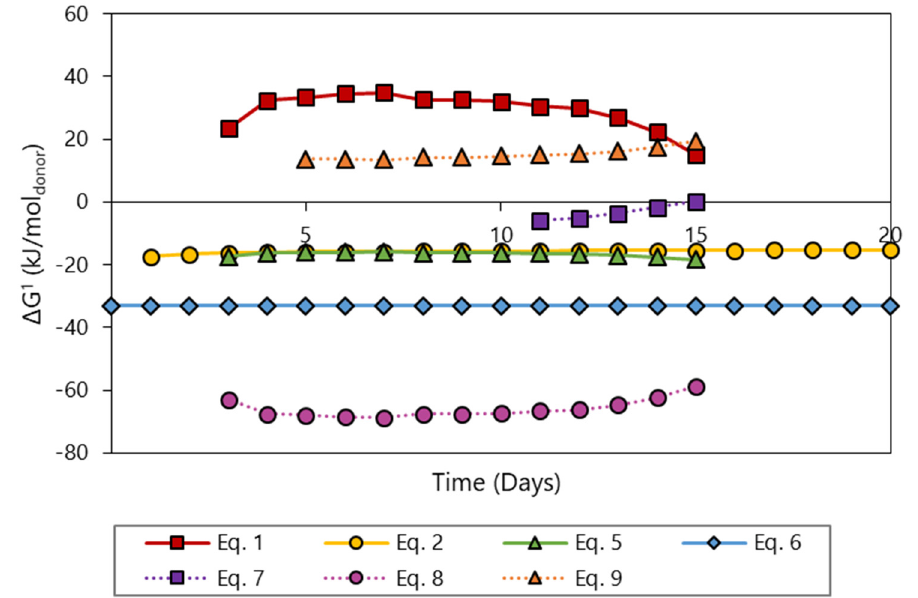
Figure 7. Actual Gibbs energy changes in kJ per mol of electron donor for (Equation (1)) butyrate oxidation to acetate, (Equation (2)) butyrate reduction to butanol, (Equation (5)) homoacetogenesis, (Equation (6)) hydrogenotrophic methanogenesis, (Equation (7)) acetate reduction to ethanol, (Equation (8)) acetoclastic methanogenesis, and (Equation (9)) lactate formation from acetate and CO 2 , with time according to experimental data in the bioreactor experiment.